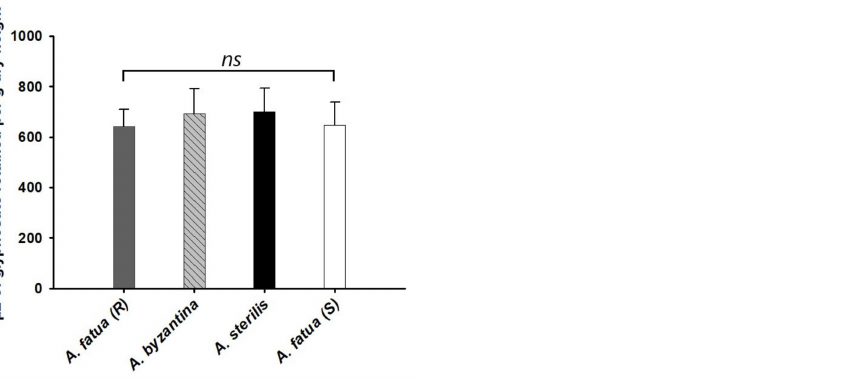
Figure 3. Spray retention of a glyphosate solution on leaves of Avena plants. Vertical bars are the standard error of the mean ( n = 12); ns = non-significant.